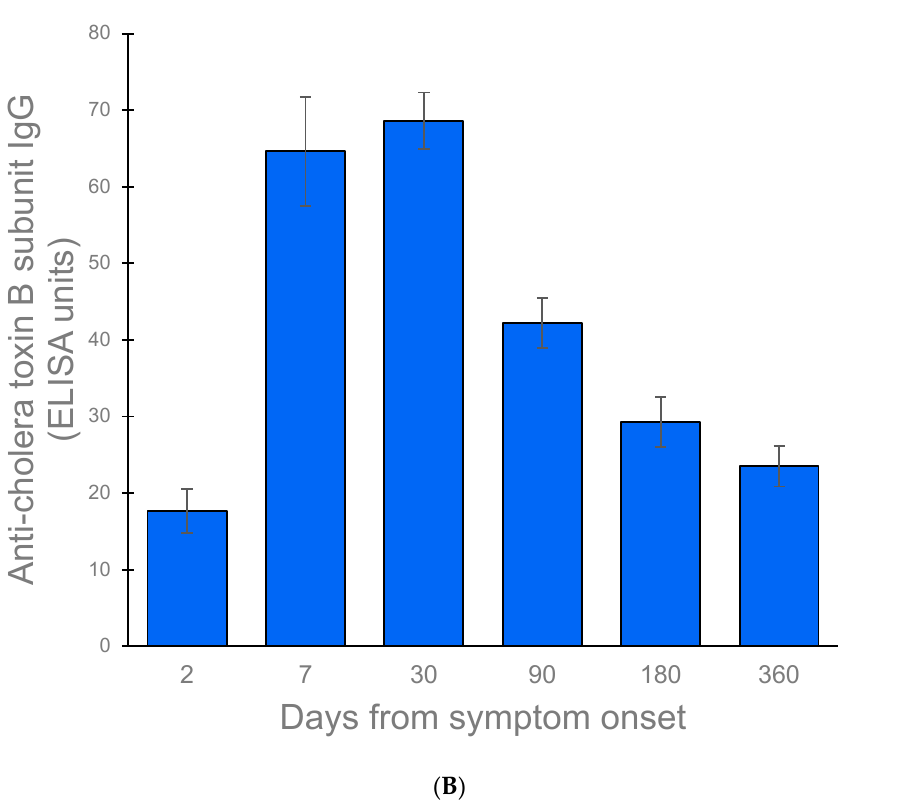
Figure 3. ( A ) Forest plots of the kinetics of anti-cholera toxin B subunit IgG following cholera [37–40,42,43]. ( B ) Kinetics of anti-cholera toxin B subunit IgG following cholera. When compared with acute infection titers on day 2, anti-CTB IgG levels were still elevated 1 year after symptom onset.